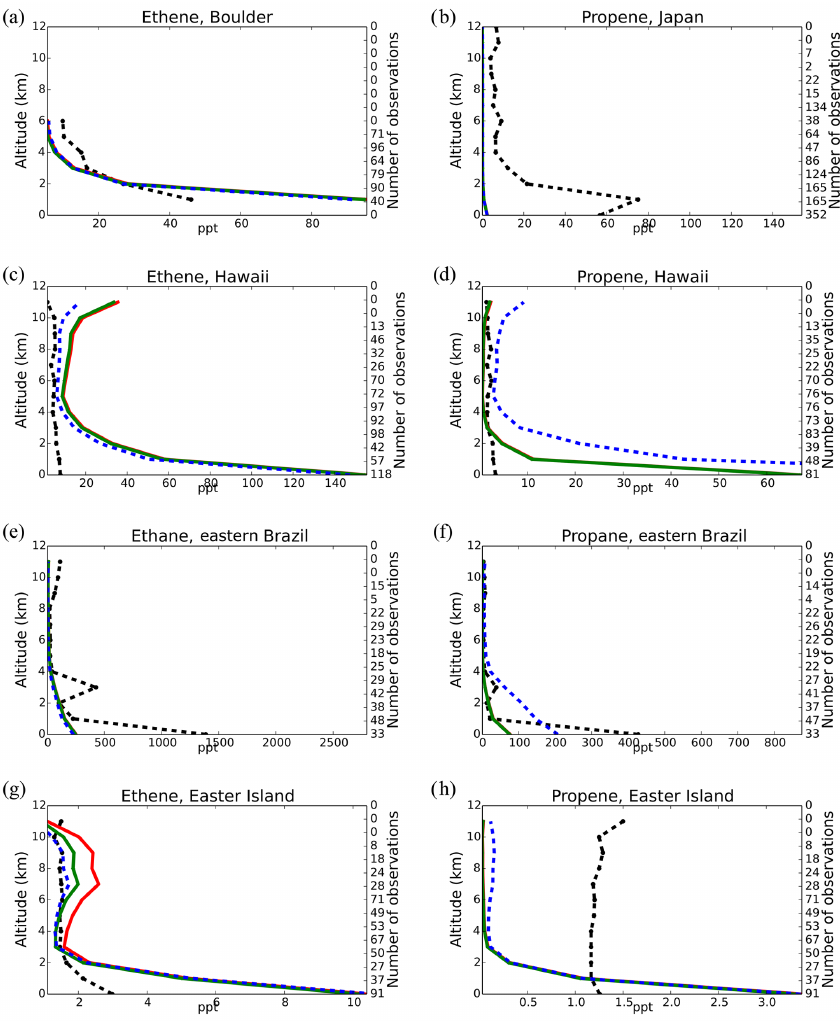
Figure 11. Comparison of TM5-MP vertical profiles (km) of C 2 H 4 (left column) and C 3 H 6 (right column) against aircraft observations (black line; ppt) for the two chemistry schemes, mCB05(KPP) (green line) and MOGUNTIA (blue line), using colocated model output for 2006 sampled at the measurement times; error bars indicate the standard deviation. For comparison, model results of mCB05 with the EBI solver (red line) are also presented. The numbers on the right vertical axis indicate the number of available